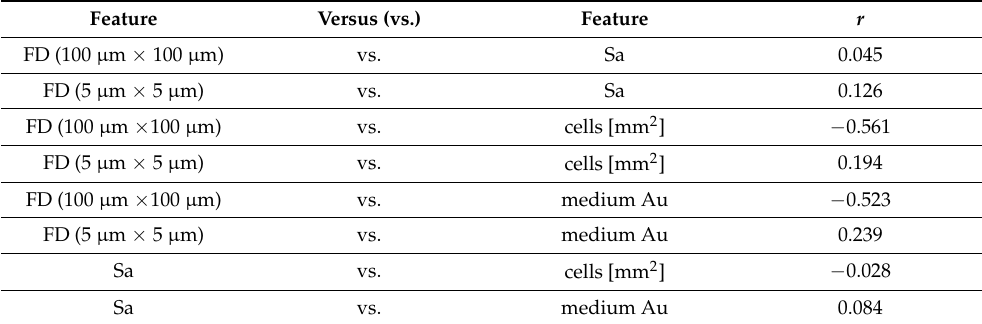
vs. cells [mm 2 ] vs. medium